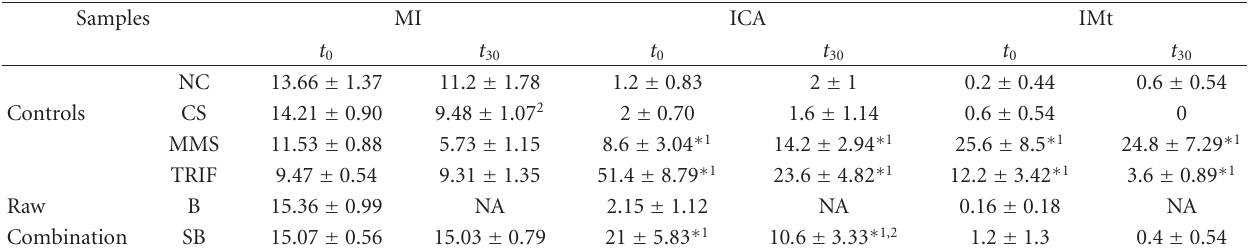
Table 3: Mean and standard deviation of the mitotic (MI), the chromosome aberration (CA), and mutagenicity indexes (IMt) in meristematic cells of Allium cepa after exposure to control soil, negative and positive controls, and biosolid samples.